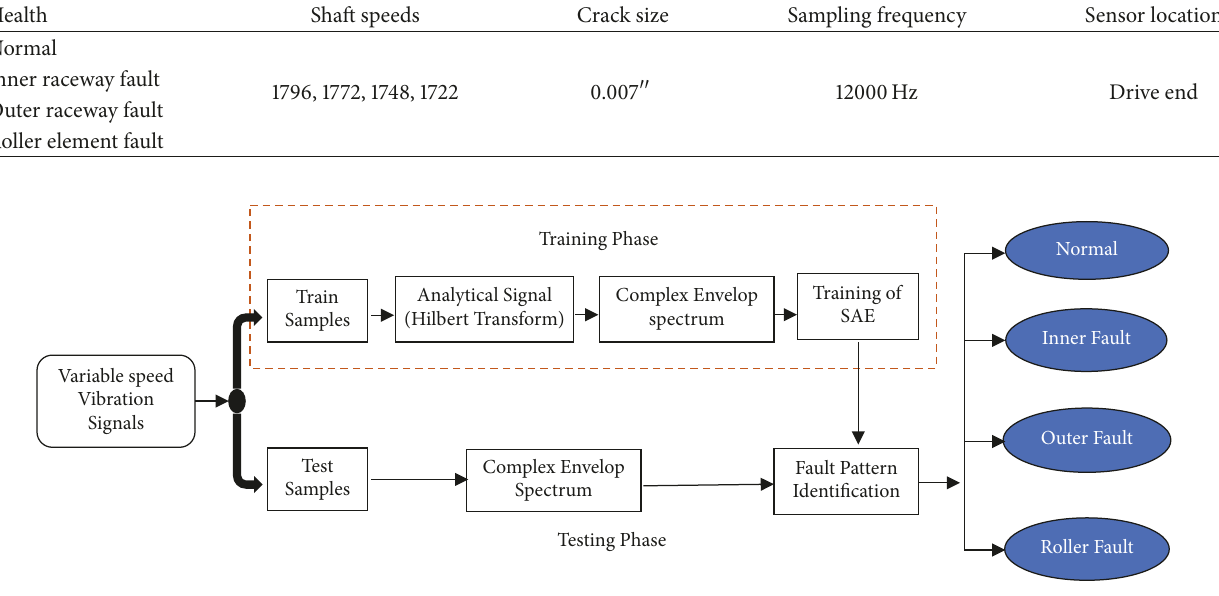
Figure 1: Illustration of the proposed fault diagnosis